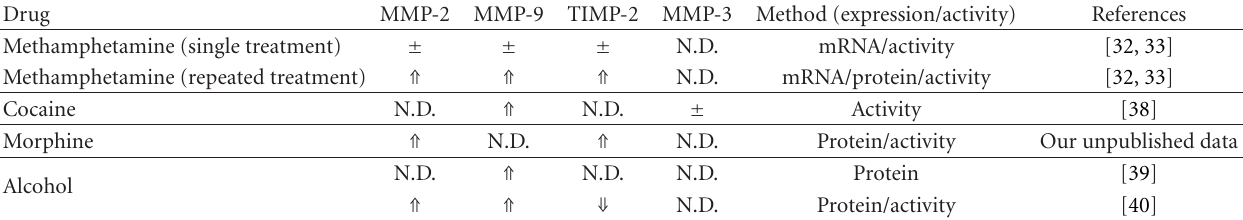
Table 3: Changes in MMP and TIMP expression levels and activities induced by drugs of